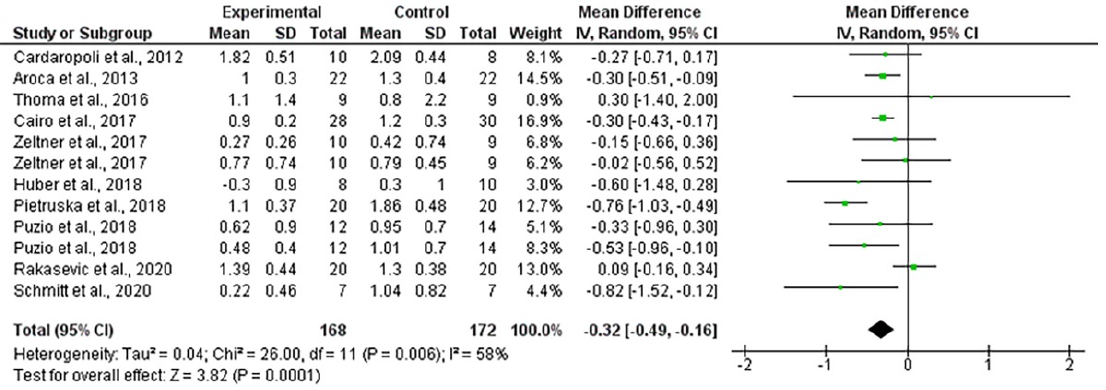
Figure 12. Forest plot for gingival thickness. Test (collagen matrix) vs. control (autogenous connective tissue) groups. The weighted mean is presented at CI 95%. Heterogeneity was determined using Higgins (I 2 ). A random-effects model was applied. Statistical significance was p < 0.001.